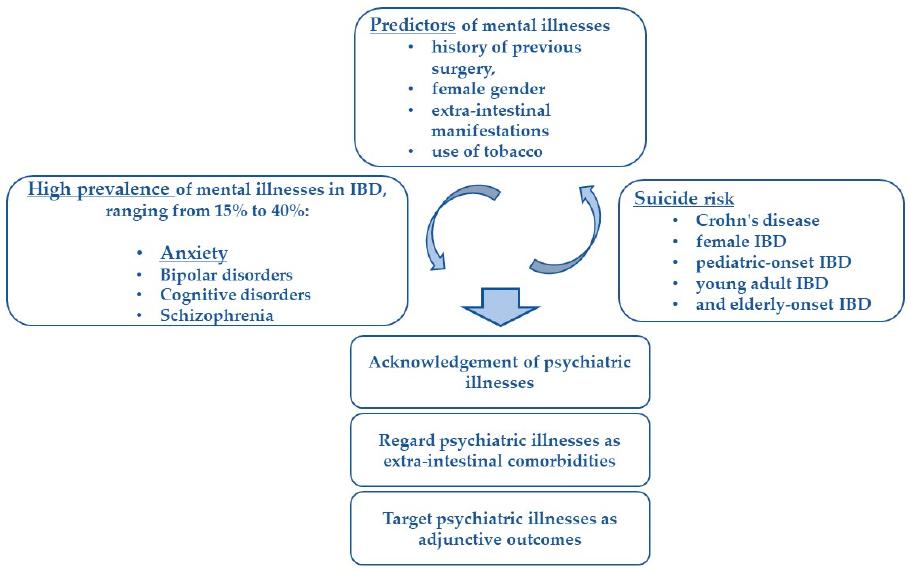
Figure 2. Integration of mental illnesses in the management of